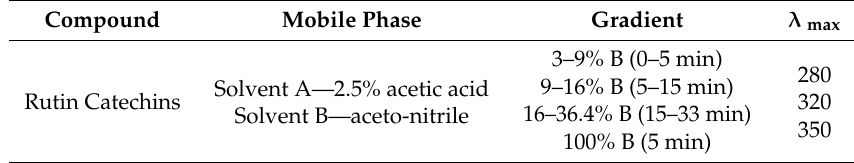
Table 4. The table represents mobile phase and their gradient